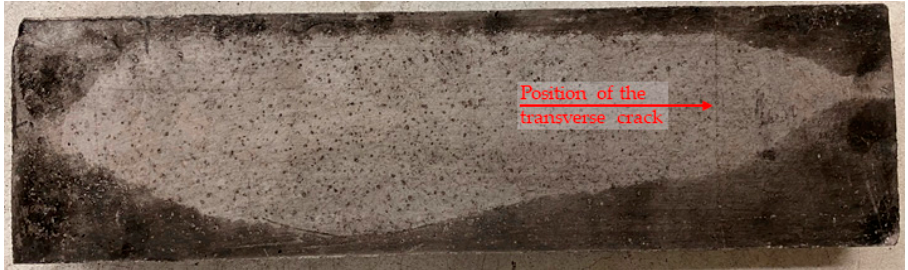
Figure 8. Test specimen with 10 mm covering layer and an addition of PP fibers in concrete mixture (HPC mixture No. 1)—the development of a transverse crack during a fire test. (HPC mixture No. 1)—the development of a transverse crack during a fire